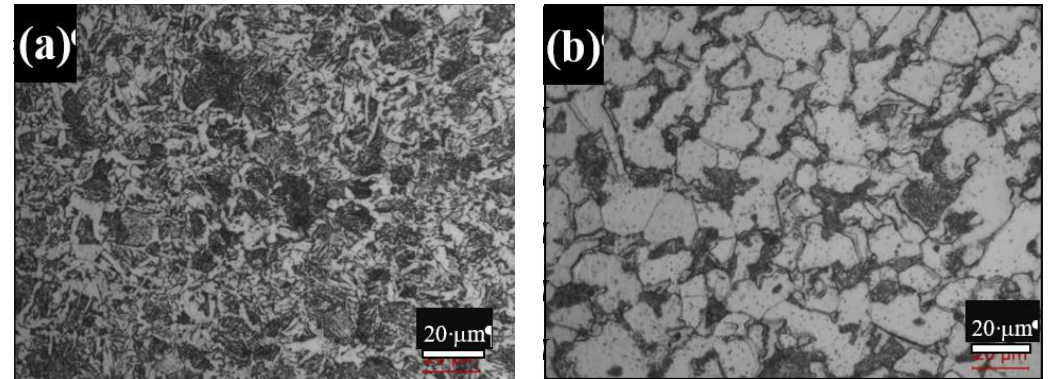
Figure 2. Microstructural images of ( a ) standard rebar and ( b ) DP steel after heat treatment.